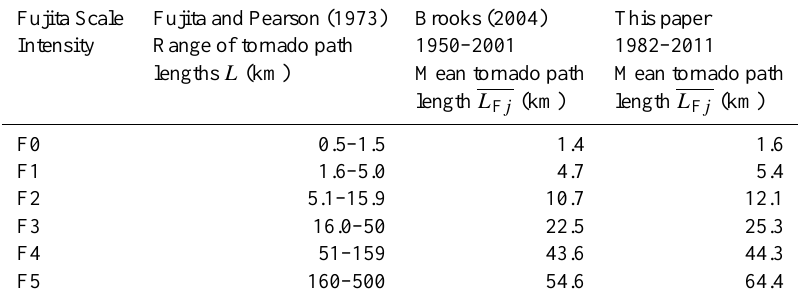
Table 1. Continental USA tornado touchdown path lengths L as a function of Fujita (or Enhanced Fujita) scale intensities F j , j = 0, 1, 2,..., 5. In the 2nd column, the range of path lengths L (km) given by Fujita and Pearson (1973) are given. In the 3rd and 4th columns, the mean tornado path lengths L F j in the continental USA given by Brooks (2004) and in this paper (Fig. 3) are given, with all path lengths L considered.